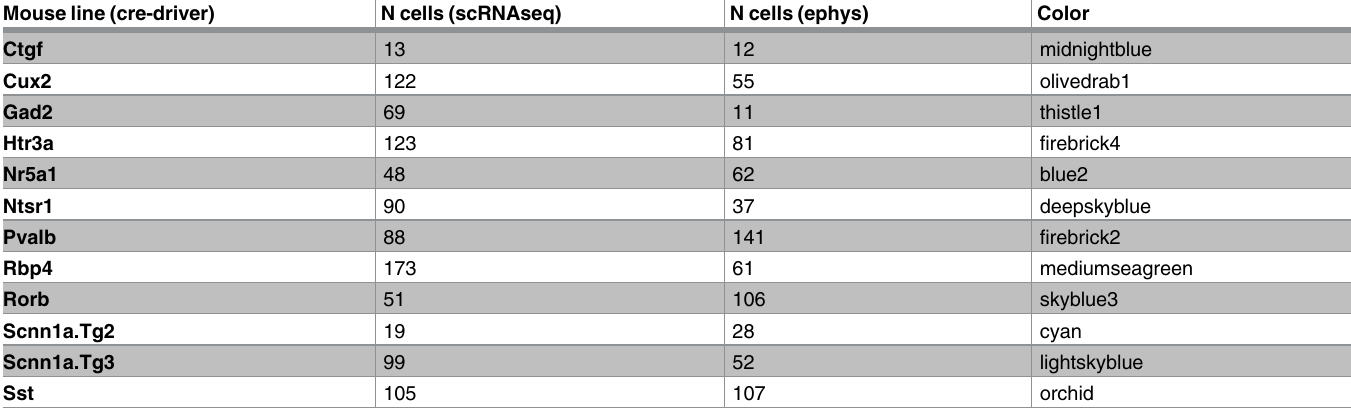
Table 2. Descriptions for neuron types composing the Allen Institutes for Brain Sciences cell types validation dataset. Mouse line indicatescre- driver lines used to label specific populationsof cells in the adult mouse visual cortex. N cells indicatesnumberof cells assayed per cre-linevia single-cell RNAseqor patch-clamp electrophysiology. Color indicatescell type color used within this manuscript. Mouse line